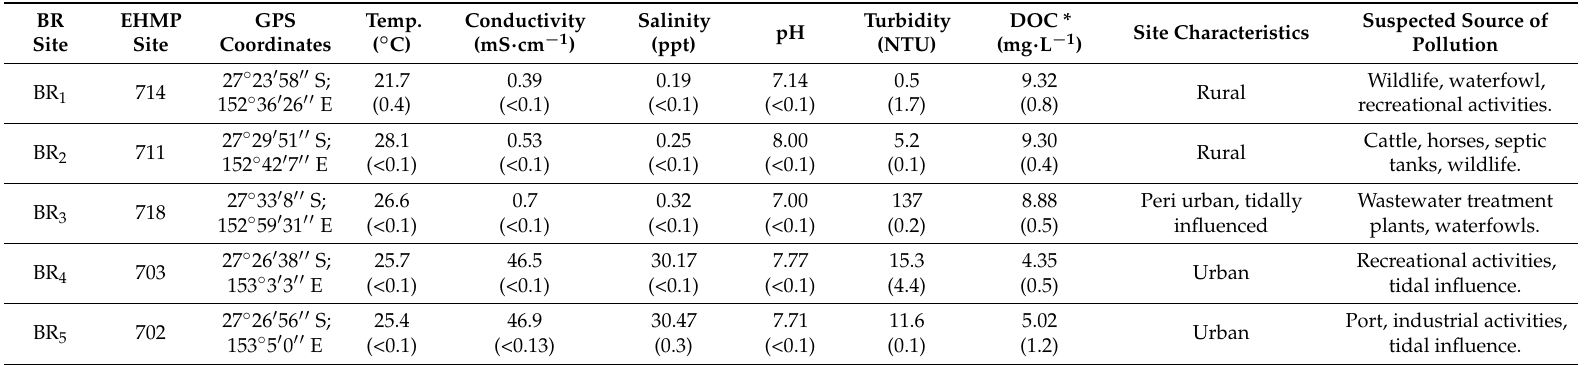
Table 1. Sample site description and in-situ water quality characteristics. Water quality parameters were analyzed in triplicate ( n = 3) and the relative standard deviation as a percentage (%RSD) are presented in the parentheses.